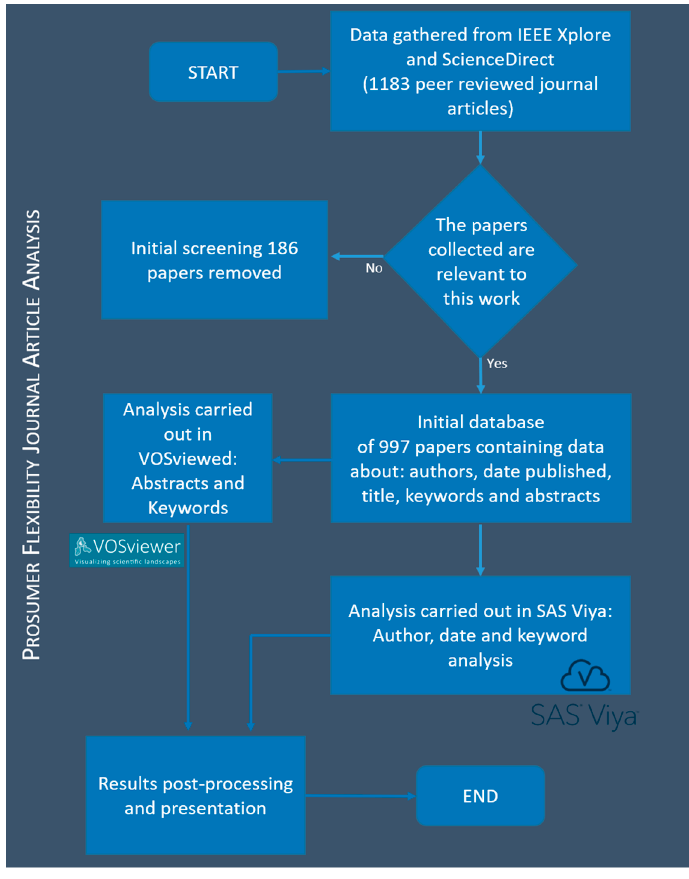
Figure 2. Methodology. Figure 2.